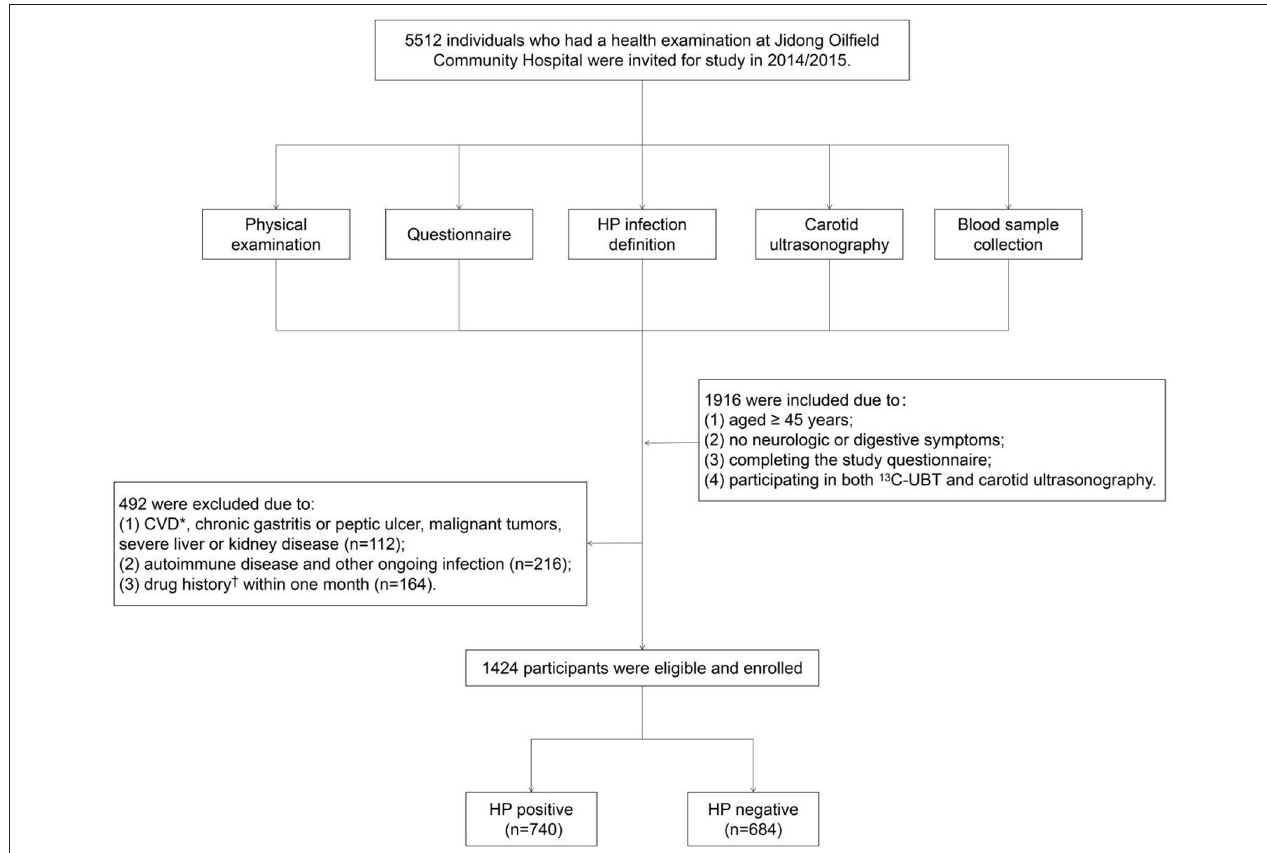
FIGURE 1 | Flow chart of the study population enrollment. *Including coronary heart disease, myocardial infarction, atrial fibrillation, heart failure, and stroke. † Drug history including aspirin, antibiotics, lipid-modulating drugs, and hormones. CVD, cardio-cerebrovascular diseases; HP, Helicobacter pylori .